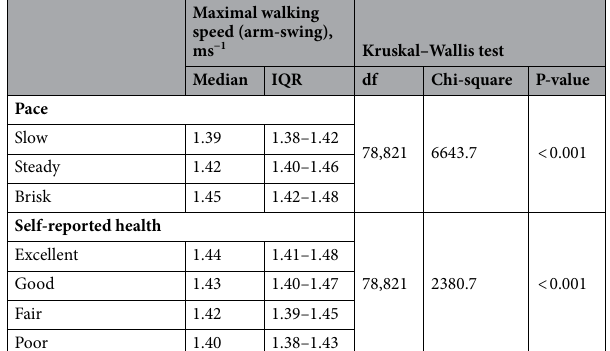
Table 2. Maximal walking speed stratified by self-reported walking pace and self-rated health (n = 78,822). P-values of the Dunn post-hoc test between each group are all < 0.001. IQR Inter-quartile range, ms − 1 m per second.